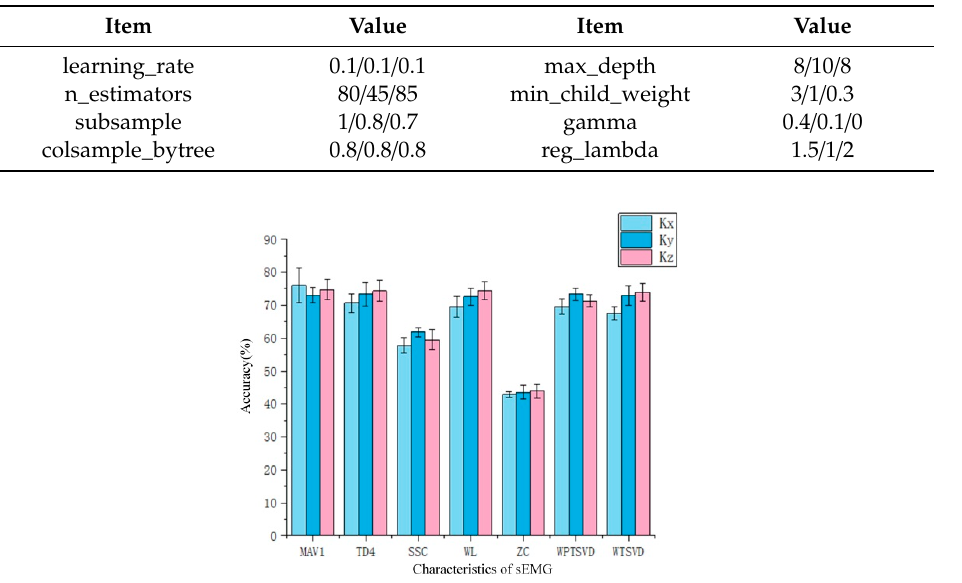
Figure 10. Confusion matrix of stiffness (MAV1) (0-high stiffness, 1-middle stiffness, 2-low stiffness). 4.4. Stiffness Mapping in Contact Space According to the stiffness classification from the sEMG signals, the classified stiffness at the human arm endpoint can be obtained in real time, which can be mapped to naturally control the stiffness of the slave robot in contact space. The overall block diagram of stiffness mapping for teleoperation is shown in Figure 11. In contact space, the CyberForce without force feedback and TrignoTM Wireless system are utilized simultaneously to teleoperate the slave manipulator. The feedback force is not applied to the human arm because it influents the stiffness of human arm. The Cartesian impedance controller in which the stiffness parameters can be adjusted is designed in the slave robot to execute the compliant tasks. The reference position P end of the impedance controller is provided by the human arm motion measured by CyberForce. Besides, the classified stiffness at the human arm endpoint end K